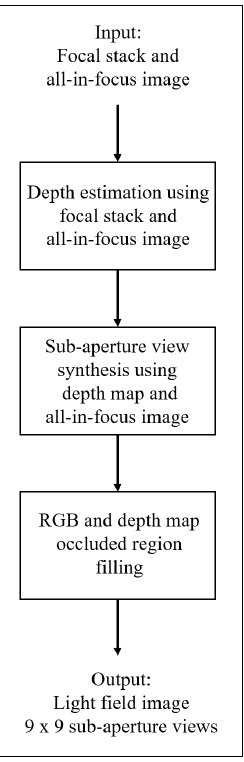
Figure 1. Light field synthesis algorithm flow.